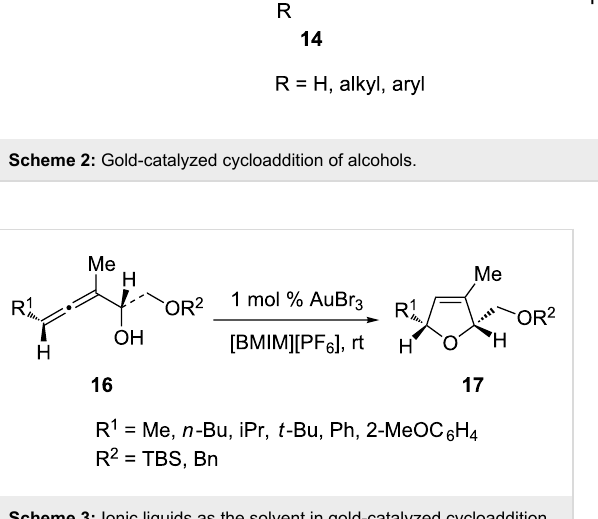
Scheme 3: Ionic liquids as the solvent in gold-catalyzed